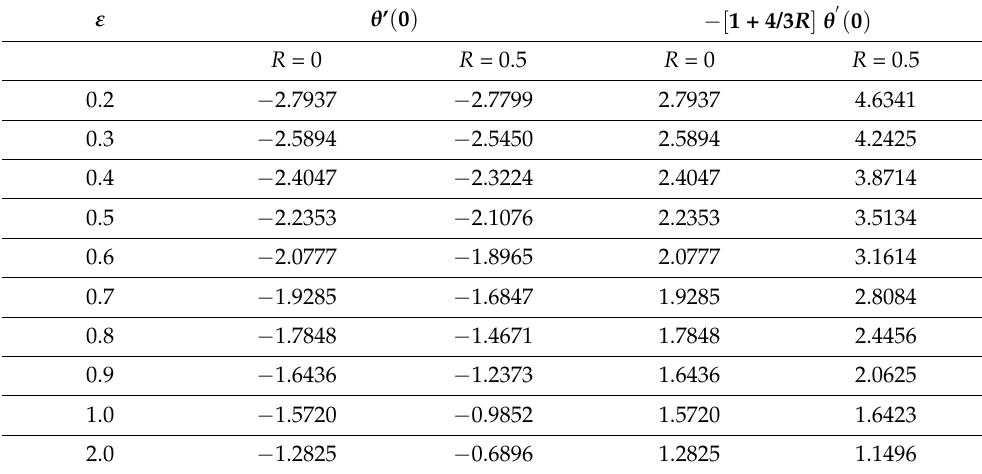
Table 14. Impact of variable thermal conductivity on Nusselt numbers for radiative and non-radiative flow fields.